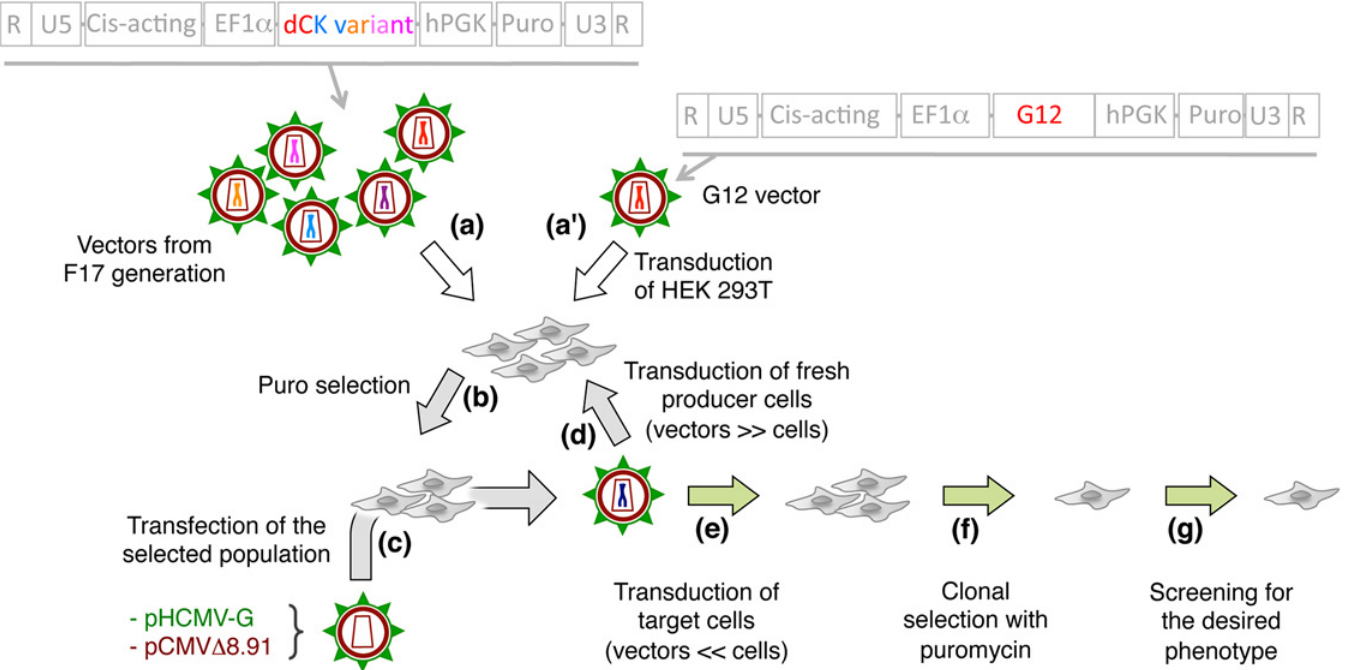
Fig 2. Scheme of the procedure followed to generate F27-RL and F11-DL. The general structure of the genomic RNAs used for retrovolution is given at the top, on the left for the F16 population and on the right for the population containing only the G12 variant. The procedure has been previously described [34] and consists in the repeated transduction of HEK 293T cells with the lentiviral vectors followed by the selection, with puromycin, of cell populations that have stably integrated the proviral DNA that has been produced by reverse transcription. Transfection of this population with the transcomplementation plasmids pHCMV-G and pCMV Δ 8.91 (see main text) allows the production of the next vector generation that is then used to transduce fresh HEK 293T cells during repeated cycles of selection, transfection and transduction. For screening purposes, target cells are transduced by less than one lentivector particle per cell, and individual clones were isolated in the presence of puromycin. Screening for sensitisation to various compounds is carried out as described in the main